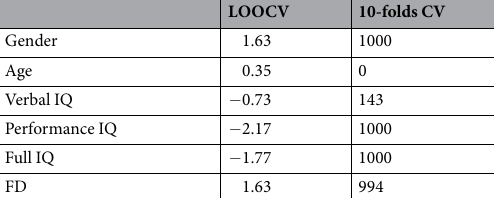
LOOCV 10-folds CV